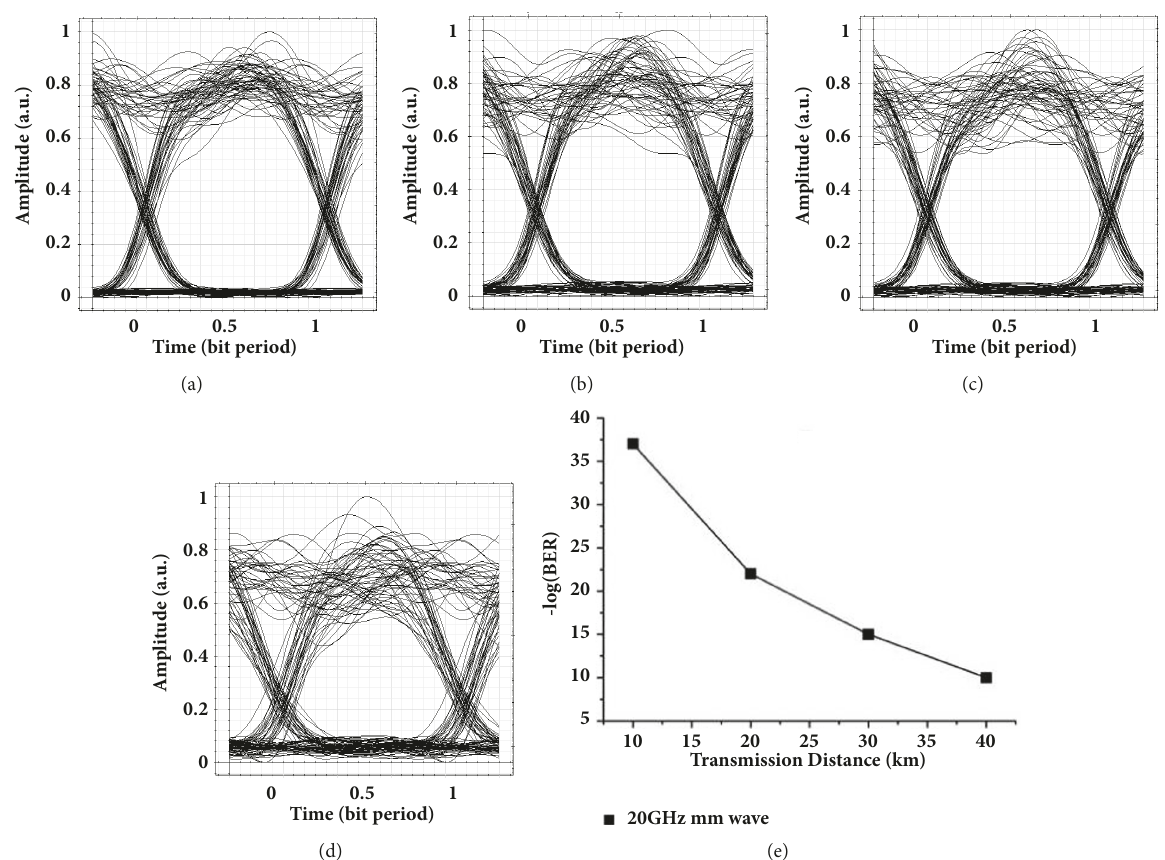
Figure 12: Baseband signal eye diagram of 20GHz mm-wave after fiber transmission over (a) 10 km, (b) 20 km, (c) 30 km, (d) 40 km, and (e) BER versus transmission